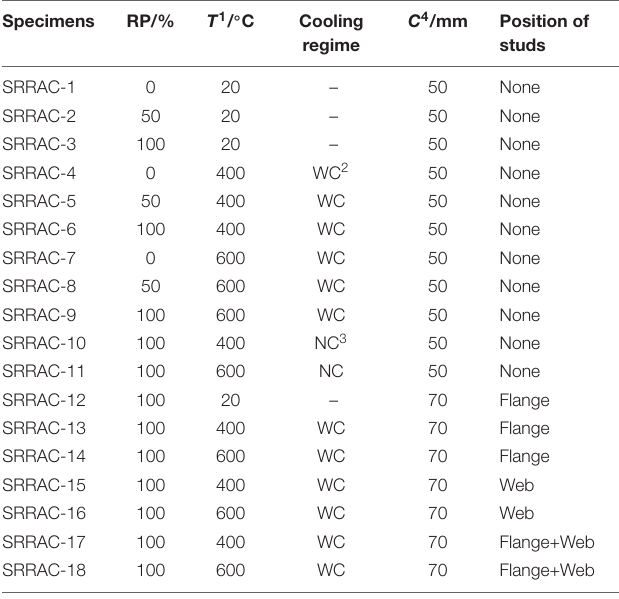
TABLE 1 | Design parameters of specimens.